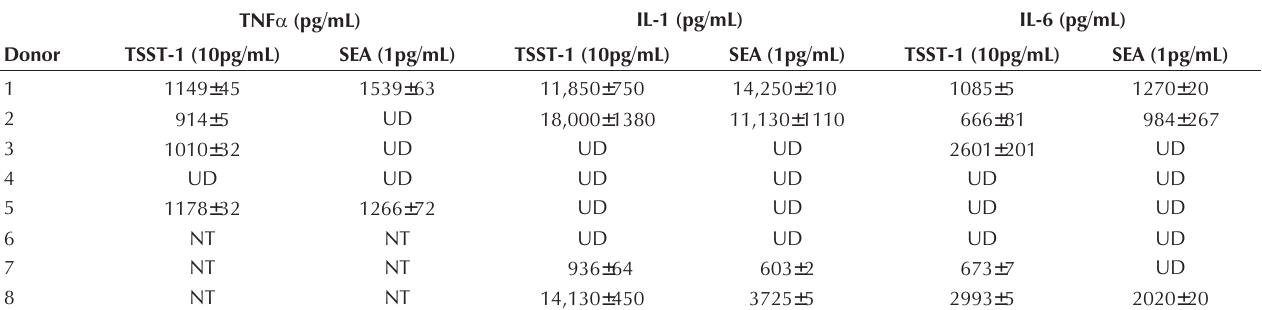
Induction of tumour necrosis factor-alpha (TNF (cid:1) ) interleukin (IL)-1 and IL-6 in culture supernatants of human peripherial blood mononuclear cells (PBMCs) from healthy donors followng stimulation with TSST-1 and SEA